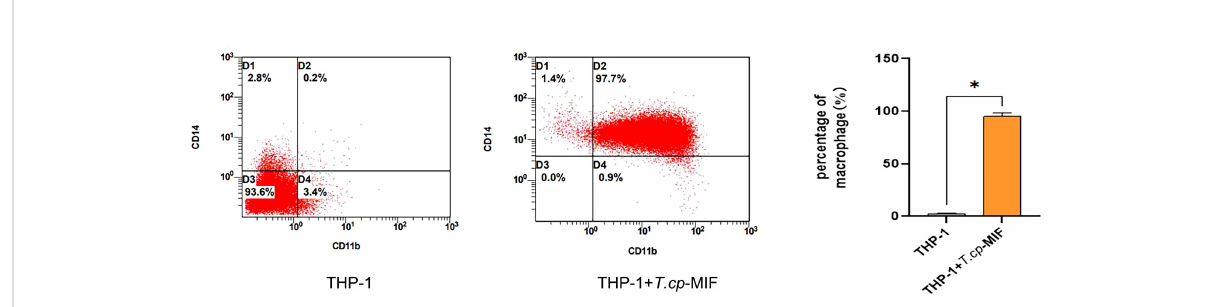
FIGURE 2 Phenotypic molecular expression in macrophages. The double-positive rate of CD11b and CD14 changed from 0.2% in suspension cells to 97.7% in adnexal cells, and the double-positive rate was greater than 95% for human THP-1-derived macrophages. * indicated P <0.05.